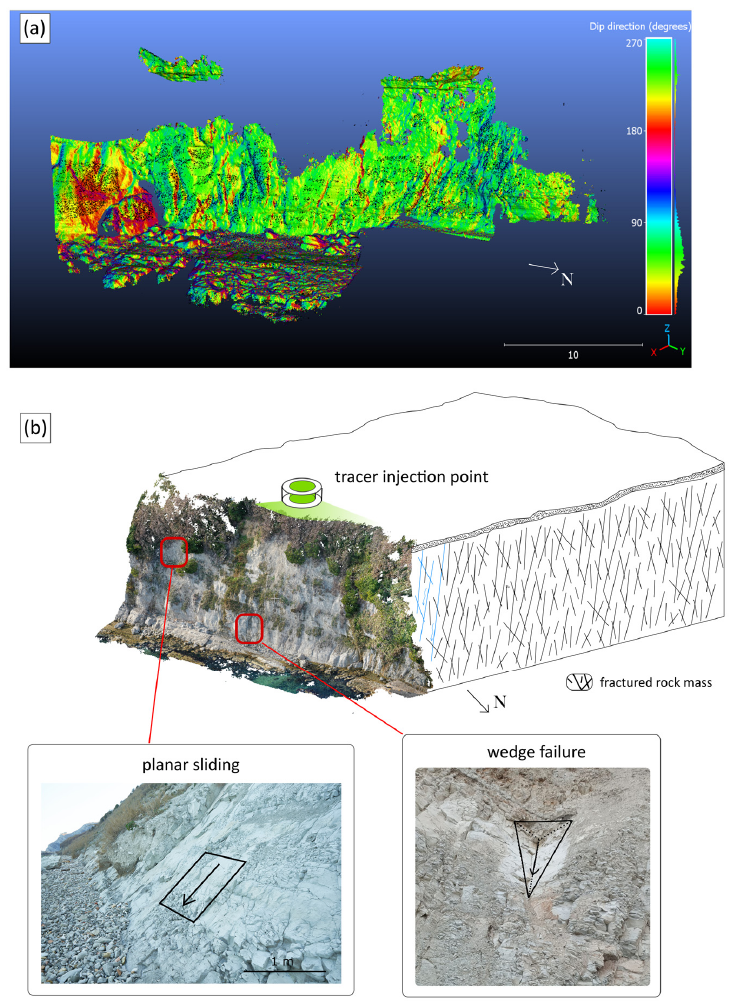
Figure 8. ( a ) Cliff orientation (dip direction) extracted from the UAV model; ( b ) rock slope kinematics observed in the area, with the location of tracer release and raw illustration of fractures and groundwater flow. Figure 9 claims the graphical results of the artificial tracer test performed in the area. The tracer infiltration in the topsoil was enhanced by the rainfall events that occurred be- tween 25 February 2022, and 26 February 2022, with a total amount of about 45 mm. The first tracer arrival occurred after about 10 days from the injection and a significant tracer amount was detected only in the C3 and C6 tracer monitoring points, located in the frac- ture set J3. Further tracer arrivals were recorded in C6 twenty days from the injection and it was preceded by minor rainfall events about twelve days before (on 3 March and 4 March 2022). The last tracer arrival was observed on 12 April 2022, in C7 (located in frac- ture set J1), likely fostered by a recharge event that started twelve days before, on 30 March 2022, and continued until 9 April with a total amount of precipitation of about 27 mm. This analysis accounts for a good correlation between the rainfall events and water move- ment within the fracture media, pointing out a stationary delay of about ten–twelve days